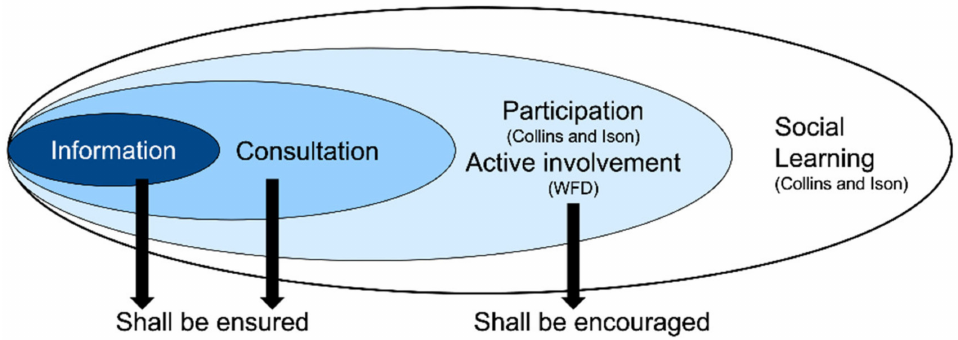
Figure 1. A conceptual framing of public participation according to the WFD (CIS 8 [9]) ranging from information to active involvement, complemented by SL according to Collins and Ison [5]. Own drawing based on both sources. Note that the policy-based formulation of the EU WFD “active involvement” is equivalent to the theory-based term of “participation”. By permission from CIS; John Wiley and Sons (License 5134971002027, 23 August